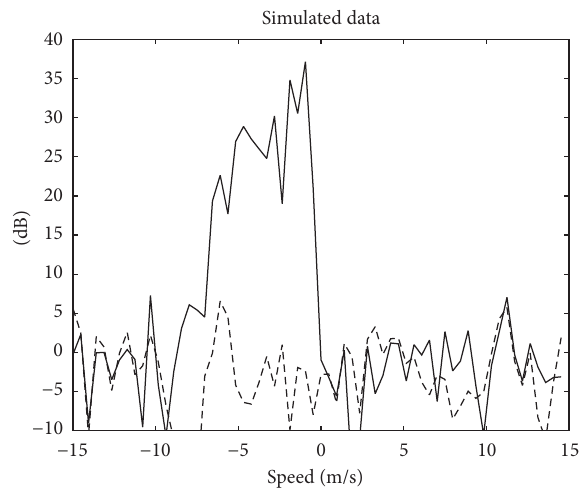
Figure 3: Comparison between sum channel (bold curve, negative speeds), deterministic (bold curve, positive speeds), and adaptive space-time processing (dash curve) on error-free simulated